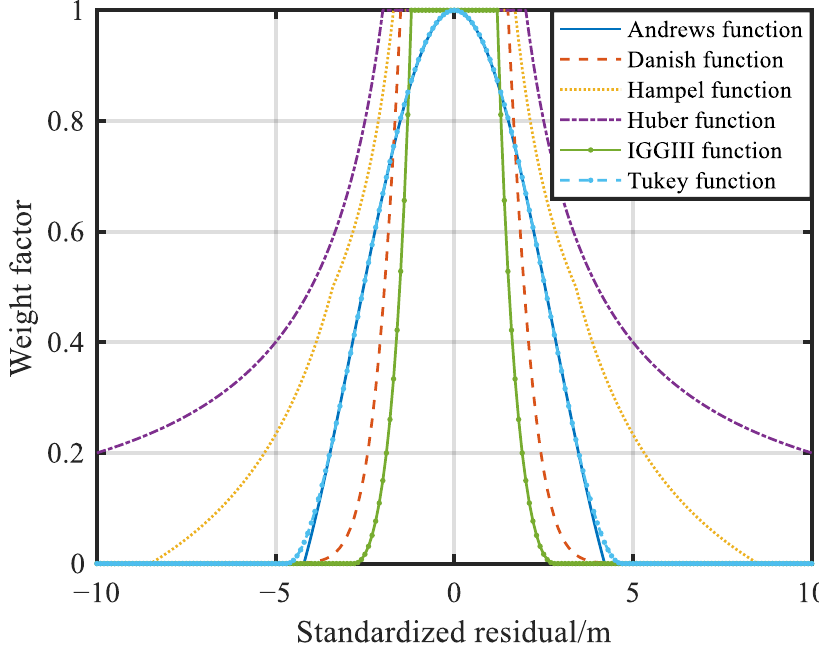
Figure 1. The weight factor of different robust estimation functions.